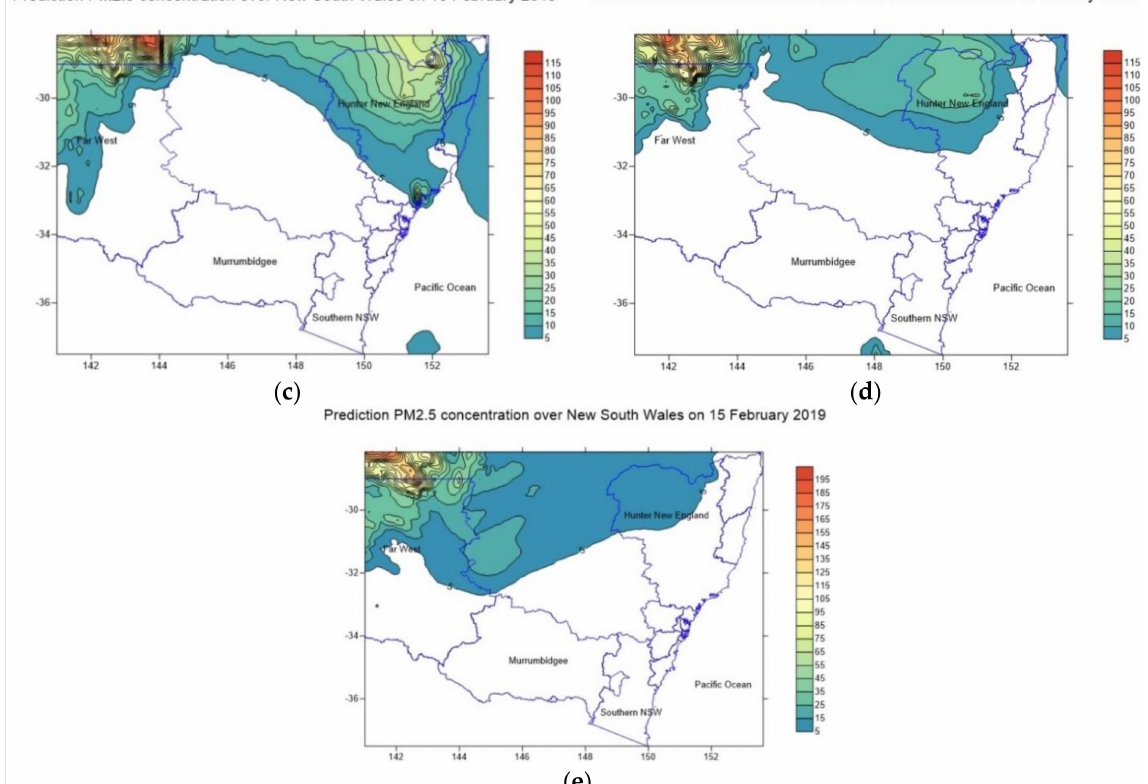
Figure 8. Daily average concentration of PM 2.5 across NSW, generated from the dust storm event, as predicted by WRF-Chem model on 11 ( a ), 12 ( b ), 13 ( c ), 14 ( d ) and 15 February 2019 ( e ).